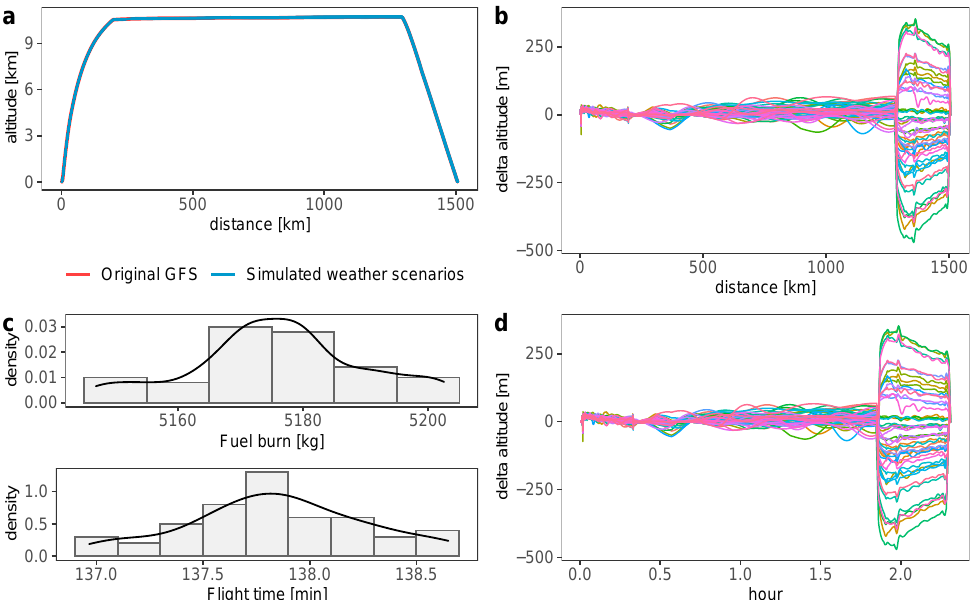
Figure 27. ( a ) The vertical profiles of the trajectories from Prague to Tunis by SOPHIA; red curve: with GFS data; blue curve: with simulated weather scenarios. ( b , d ) The chromatic line plots present the altitude differences between trajectories with simulated weather scenarios and GFS